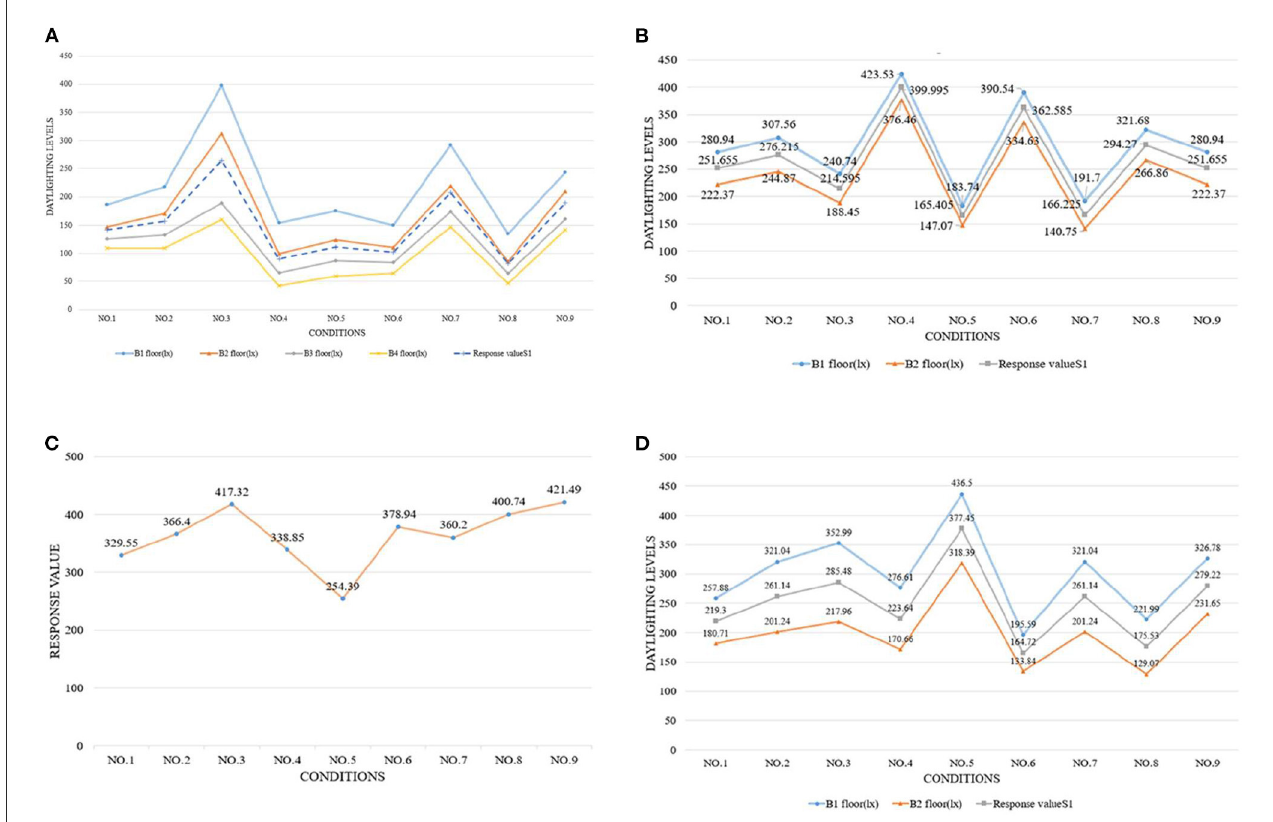
FIGURE4 Luminous environment simulation results and response values for (A) TUAI, (B) TCAI, (C) TCSI, and (D) THAI. Image source: self-drawn by the